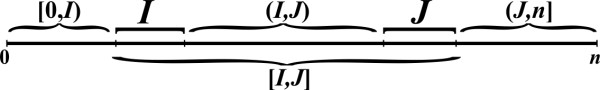
Some interval examples.